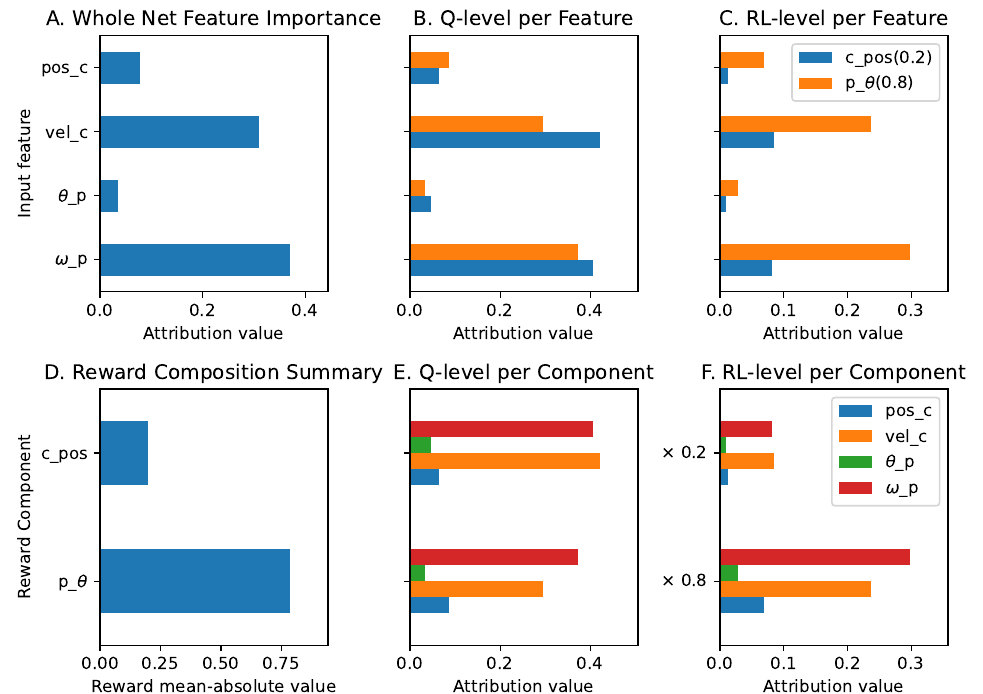
Figure A2. The global explanations of the cartpole agent.